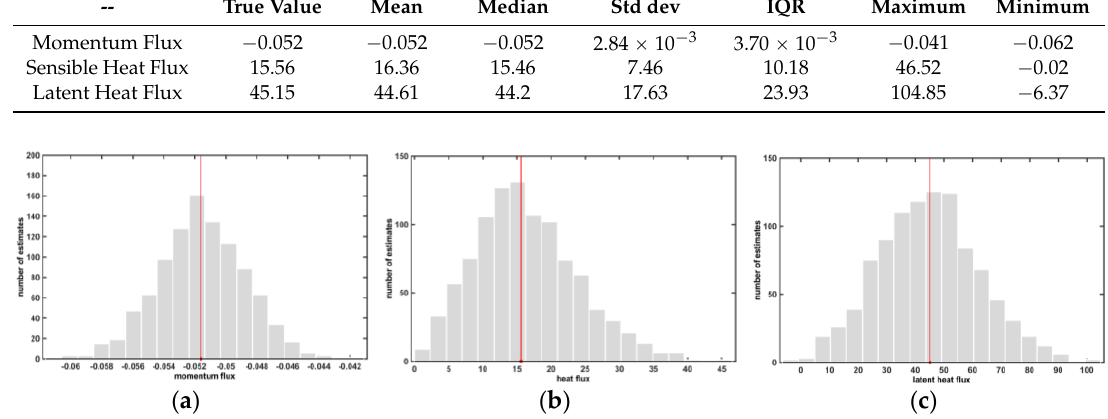
Figure 7. Histograms of ( a ) momentum; ( b ) sensible heat; and ( c ) latent heat fluxes retrieved from the synthetic datasets. The units for the fluxes are the same as those in Table 1.